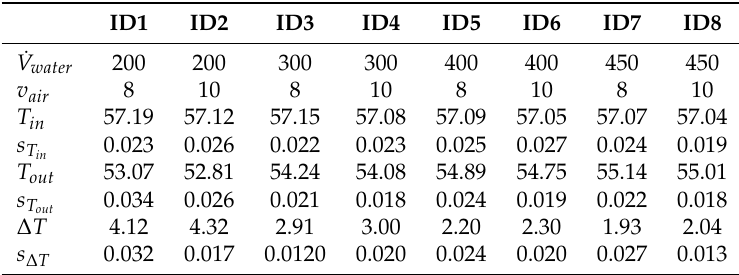
Table 4. Results of measurement in position A.